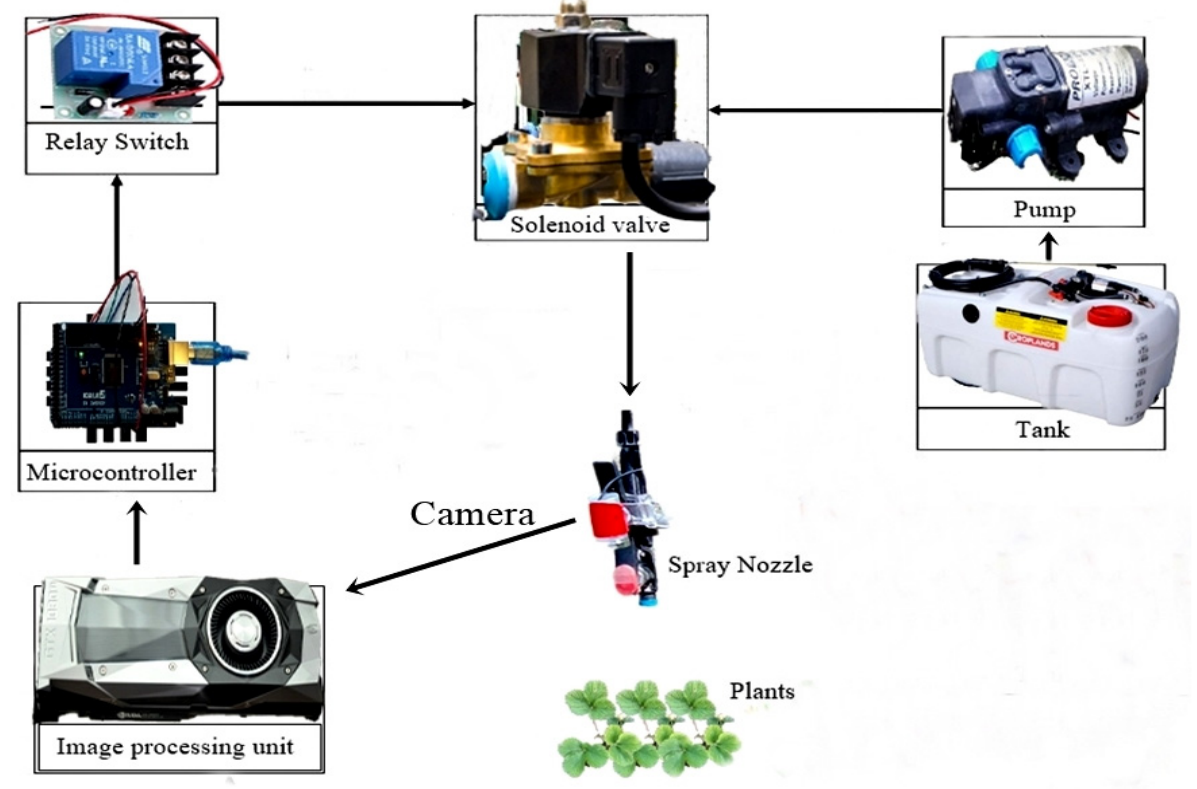
Figure 1. The overall configuration of the variable rate spraying system.